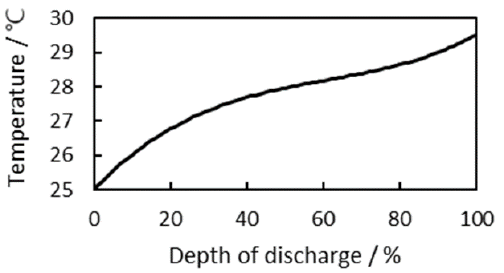
Figure 6. The temperature change of the battery cell during discharging at 1C current. To measure the cell impedance at each constant temperature, cell impedances are measured through an EIS instrument (IM6ex from Zahner-Elektrik GmbH & CoKG) in a temperature chamber set to 20, 25, 30, and 35 °C. The measurement conditions are shown in Table 3. Table 3. Parameters for EIS measurement (Galvanostatic).